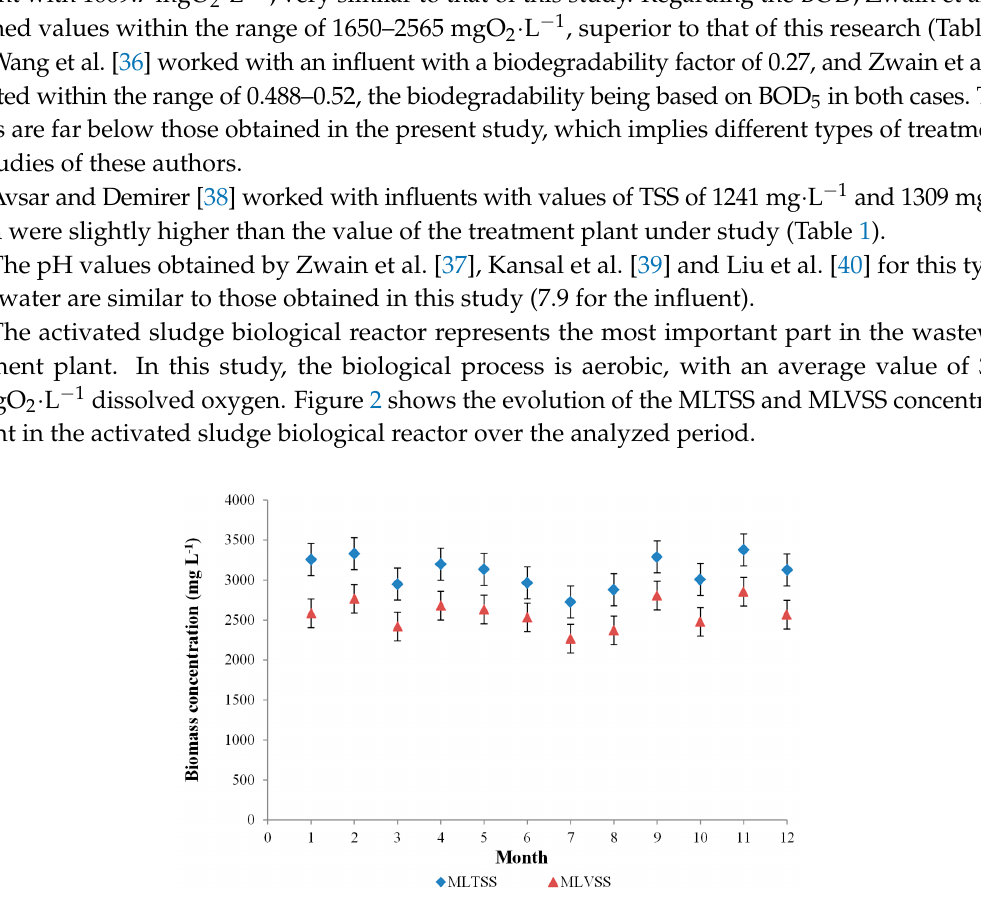
Figure 2. Evolution of mixed liquor total suspended solids (MLTSS) and mixed liquor volatile suspended solids (MLVSS).